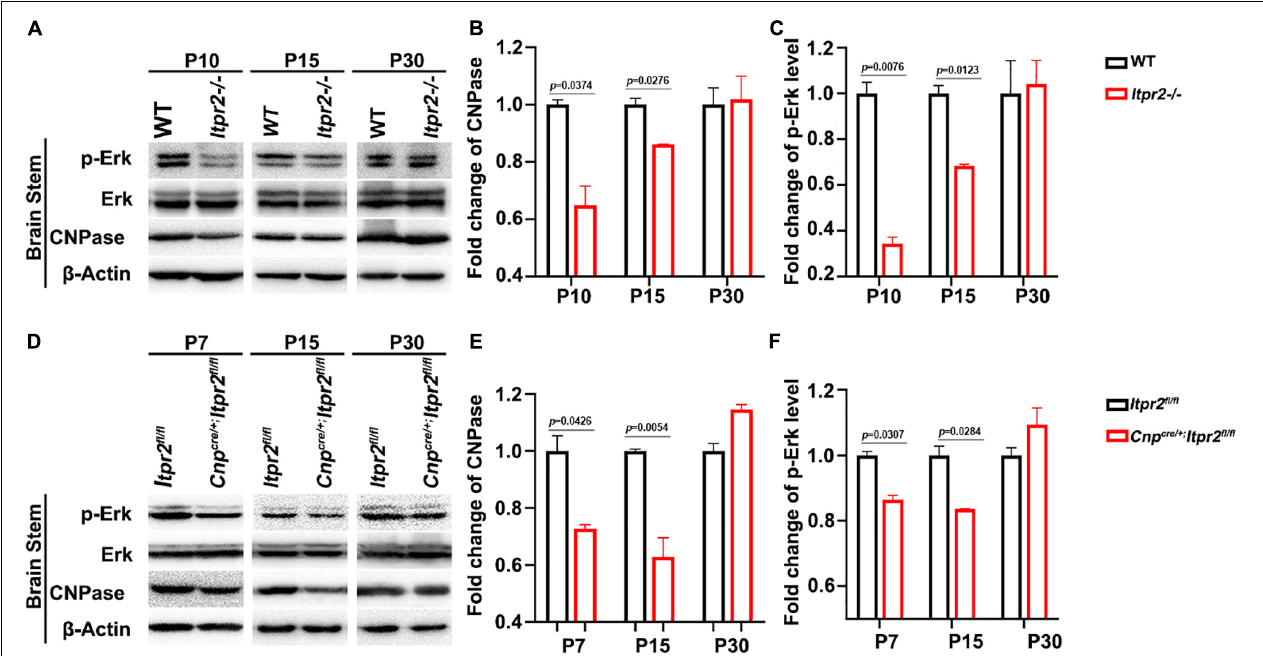
FIGURE 6 | Itpr2 deletion inhibits the Ca 2 + -dependent ERK activation. (A) The expression and phosphorylation of ERK, CNPase and ERK in brainstem tissues from wild-type and Itpr2 − / − mice at P10, P15 and P30 in grouping image. β -actin was used as the internal control. (B) Quantification of CNPase protein level in the brainstem of Itpr2 − / − mice which were normalized to the wild-type group. (C) Quantification of ERK1/2 phosphorylation level in the brainstem of Itpr2 − / − mice which were normalized to the wild-type group. (D) The expression and phosphorylation of ERK, CNPase, and ERK in brainstem tissues from control and Cnp cre / + ; Itpr2 fl / fl mice at P7, P15, and P30 in grouping image. β -actin was used as the internal control. (E) Quantification of CNPase protein level in the brainstem of Cnp cre / + ; Itpr2 fl / fl mice which were normalized to the control group. (F) Quantification of ERK phosphorylation level in the brainstem of Cnp cre / + ; Itpr2 fl / fl mice which were normalized to the control group. Error bar indicates Means ± SEM. n =